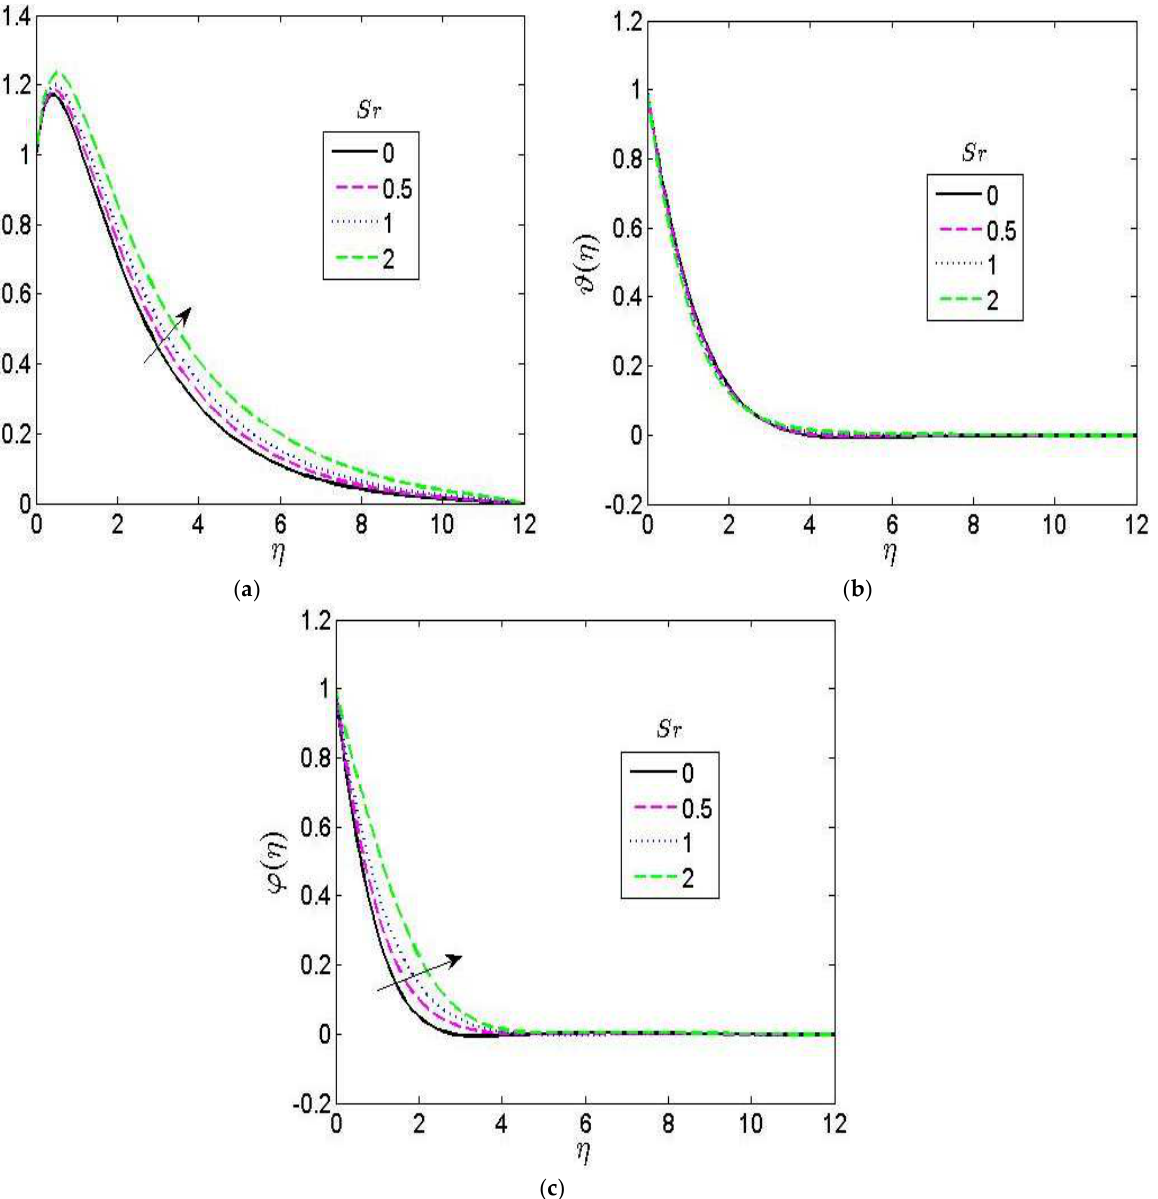
Figure 9. Effect of Soret parameter Sr on ( a ) velocity, ( b ) temperature, and ( c ) concentration profiles. The contribution of the viscoelastic term ( b ) (i.e., Weissenberg numeric) is plotted in Figure 10. The viscoelastic parameter b describes the influence of the coefficient of normal stress on the motion. Figure 10a portrays the contribution of the viscoelastic term on the velocity graph. It is detected from the graph that at any moment in the flow regime, an increase in b produces a drastic degeneration in the velocity of the fluid, whereas we ob- served in this study that a higher value of the viscoelastic term has no contribution to the temperature and concentration plot as depicted in Figure 10b,c. The result in Figure 10a signifies that a higher value of b has the tendency to decrease the hydrodynamics layer thickness.